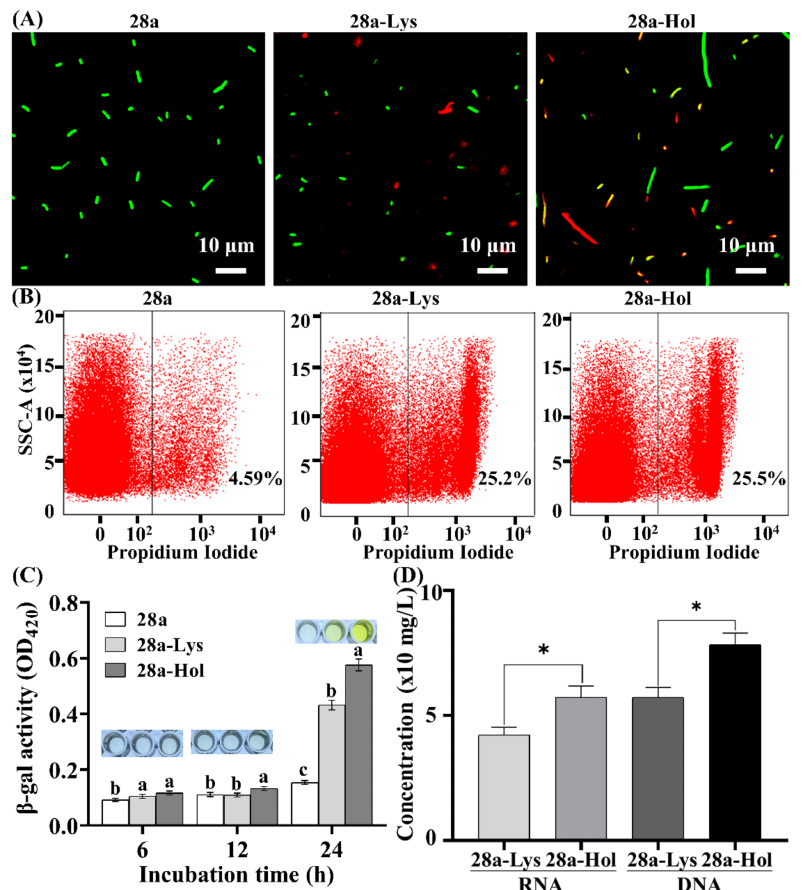
Figure 7. Effect of X2-Lys and X2-Hol on integrity of cell membrane. ( A ) Live and dead bacterial staining after 24 h post-induction. ( B ) Flow cytometry observation after 24 h post-induction. Percentages shown in each image represents the ratio of dead cells to the total cells. ( C ) β -galactosidase activity (OD 420 ) after 6, 12 and 24 h post-induction. Different lowercase letters above each bar represent significant difference ( p < 0.05) in β -galactosidase activity among the three groups of 28a, 28a-Lys and 28a-Hol at the same time point. ( D ) The release of DNA/RNA after 24 h post-induction ( n = 5). Asterisks (*) above the bar represent significant differences ( p < 0.05) in RNA or DNA concentrations between 28a-Lys and 28a-Hol groups. 28a-Lys/Hol, 28a carrying